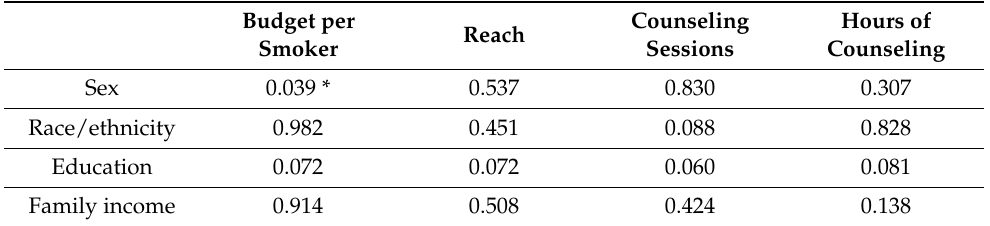
Table A4. Unadjusted multiplicative p -values a associated with interaction terms between quitline exposure variables and sociodemographic variables for 30-day smoking cessation.